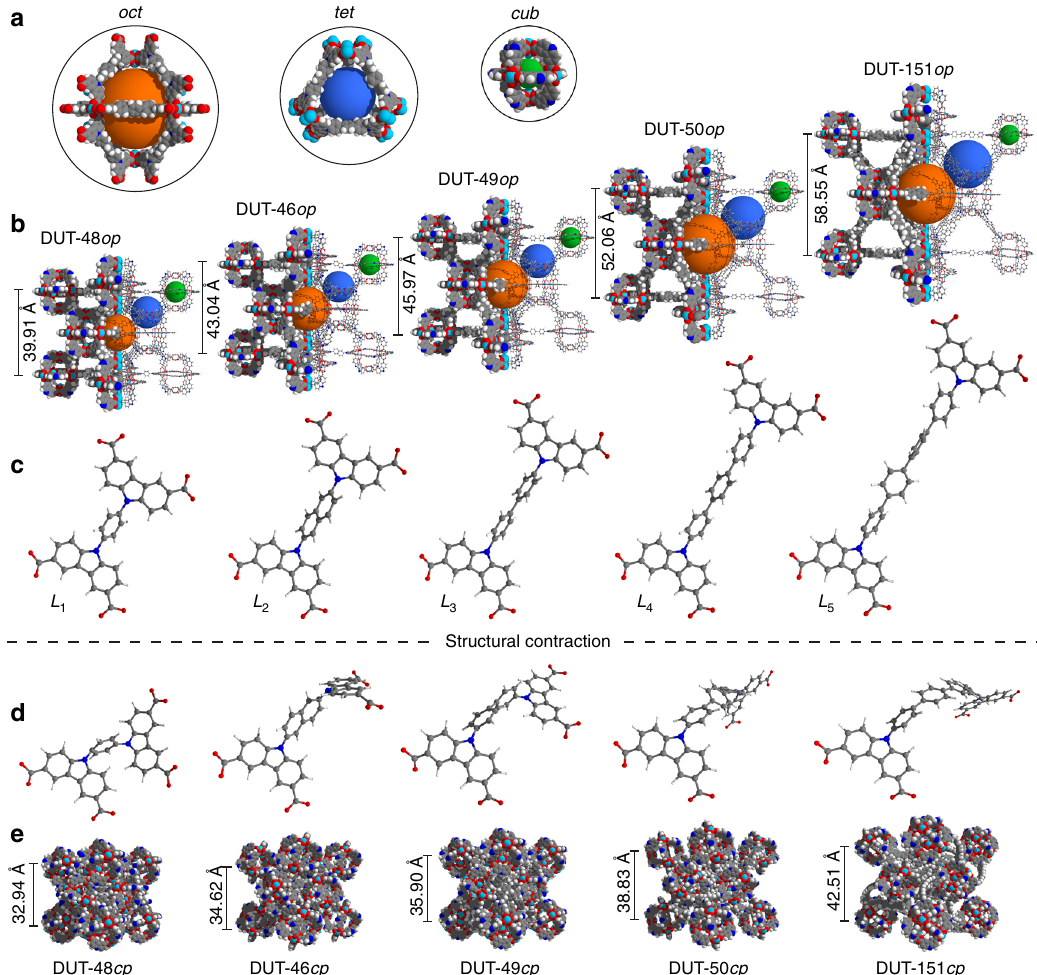
Fig. 1 Crystal structures and ligands of isoreticular DUT-49 derivatives. a Trimodal pore system: octahedral (oct, orange), tetrahedral (tet, blue), cuboctahedral (cub, green). b Crystal structures of open pore ( op ) of DUT-48, -46, -49, -50, and non-interpenetrated DUT-151 from left to right including respective lattice parameter of the cubic unit cells with Fm (cid:1) 3 m symmetry. Conformation of ligands L 1 – L 5 before ( c ) and after ( d ) structural contraction. e Crystal structures of contracted pore (cp ) structures of DUT-48, 46, 49, 50, and non-interpenetrated DUT-151 from left to right including respective lattice parameter of the cubic unit cells with Pa (cid:1) 3 symmetry. Lattice constants for the structures were obtained by relaxation using force fi elds which were found to describe the behaviour of DUT-49 well 29, 37 . Colour code: hydrogen (white), carbon (grey), nitrogen (blue), oxygen (red), and copper